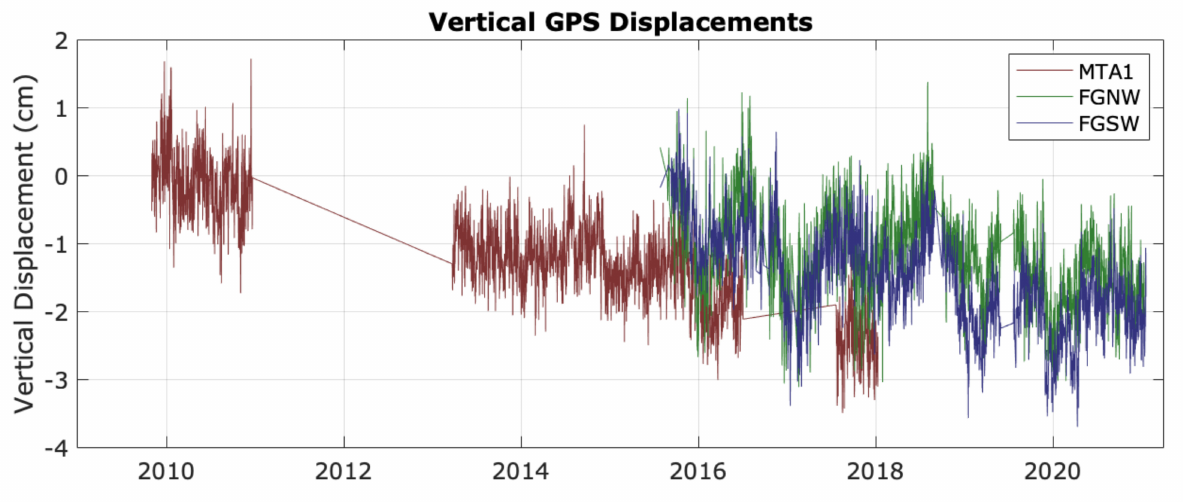
Figure 3. GPS data from stations MTA1, FGNW, and FGSW from 2009 to